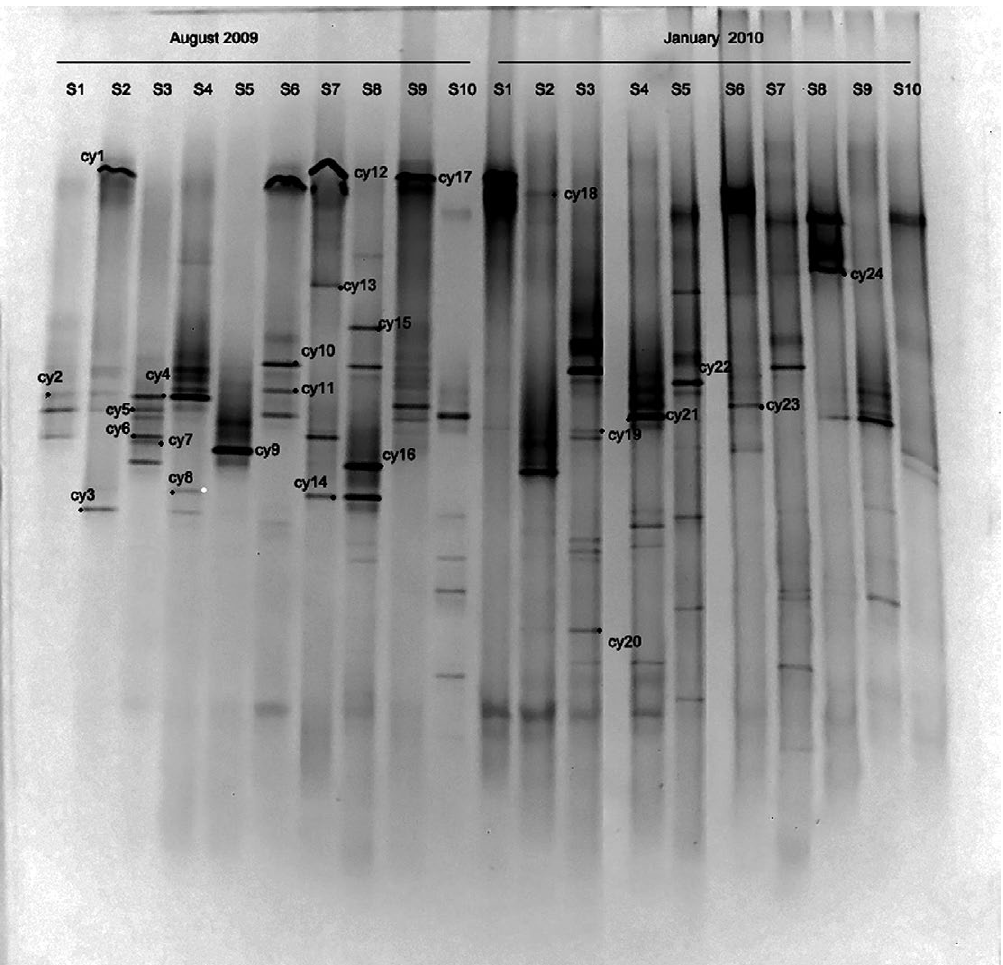
Fig. 3. – DGGE analysis of cyanobacteria in the Pearl River Estuary sediment. Labels of S1-S10 at the top of the lanes represent corresponding sampling sites. Sequencing bands have been